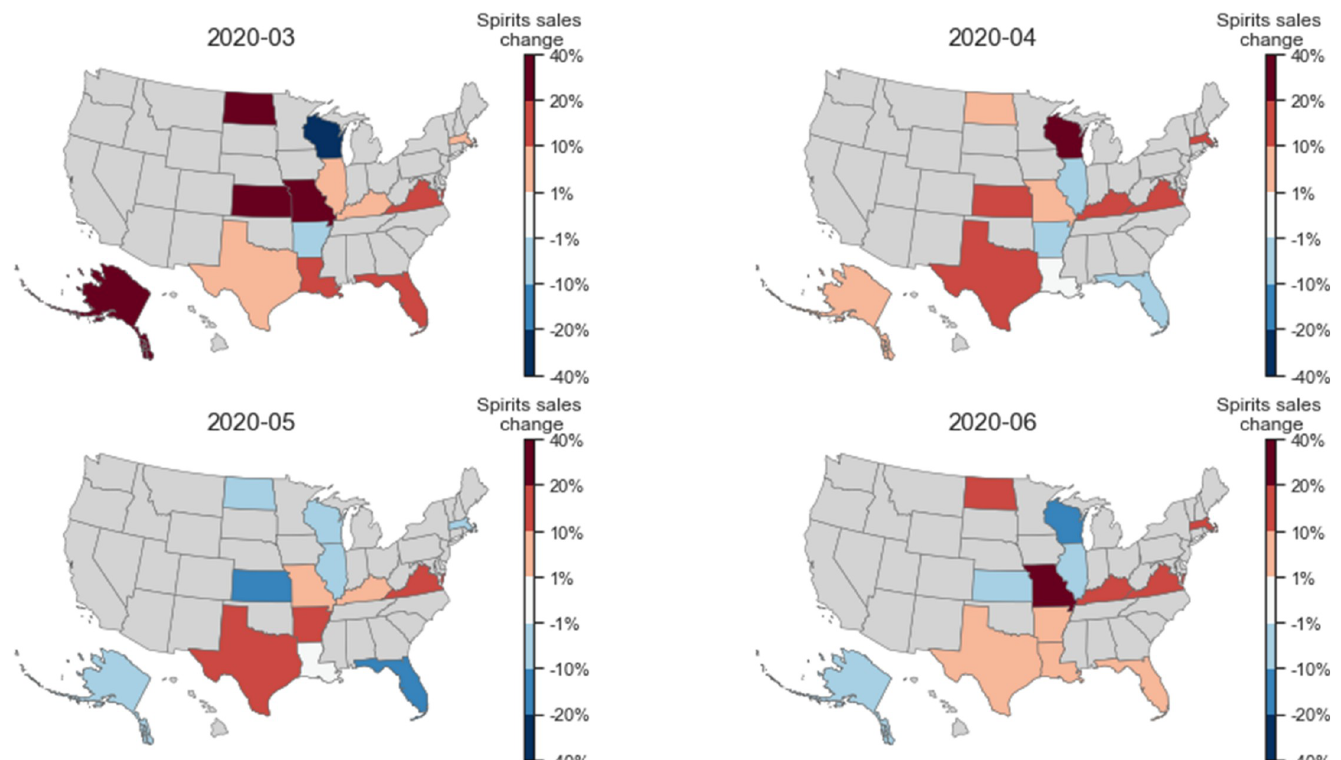
Fig 4. Geographic differences for how the per capita sales of spirits changed during the pandemic. The percentage change for each state is compared to the average sales during the same months in 2018 and 2019. Red colors indicate an increase in spirits sales, while blue colors indicate a decrease in sales. The darker the colors, the larger the changes.